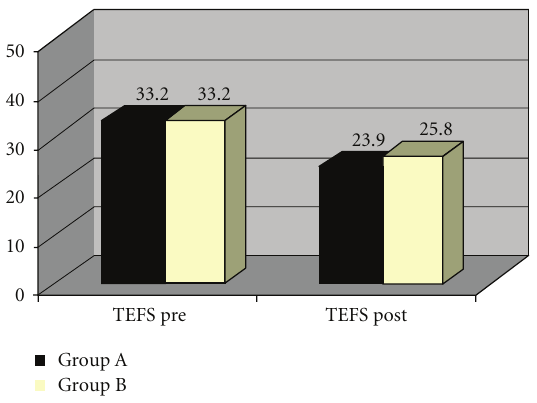
Figure 8: Comparison of TEFS scores of two